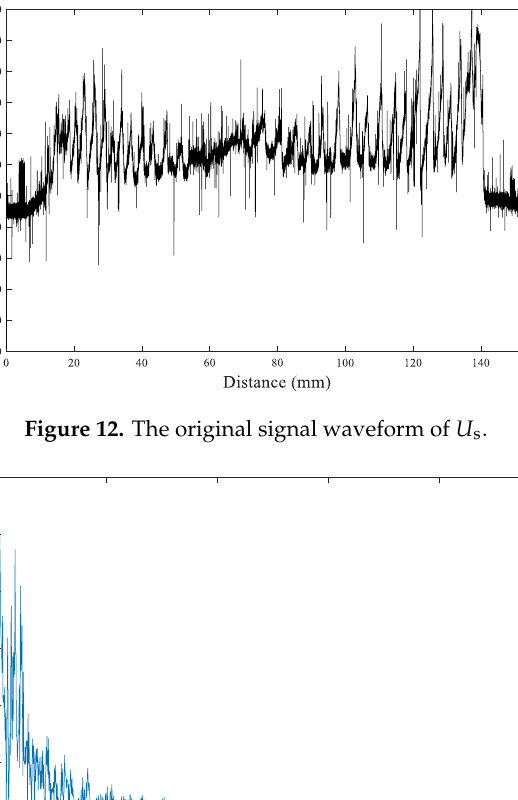
10 of 17 Figure 11. The operation of the microdestructive tree-ring measurement system.